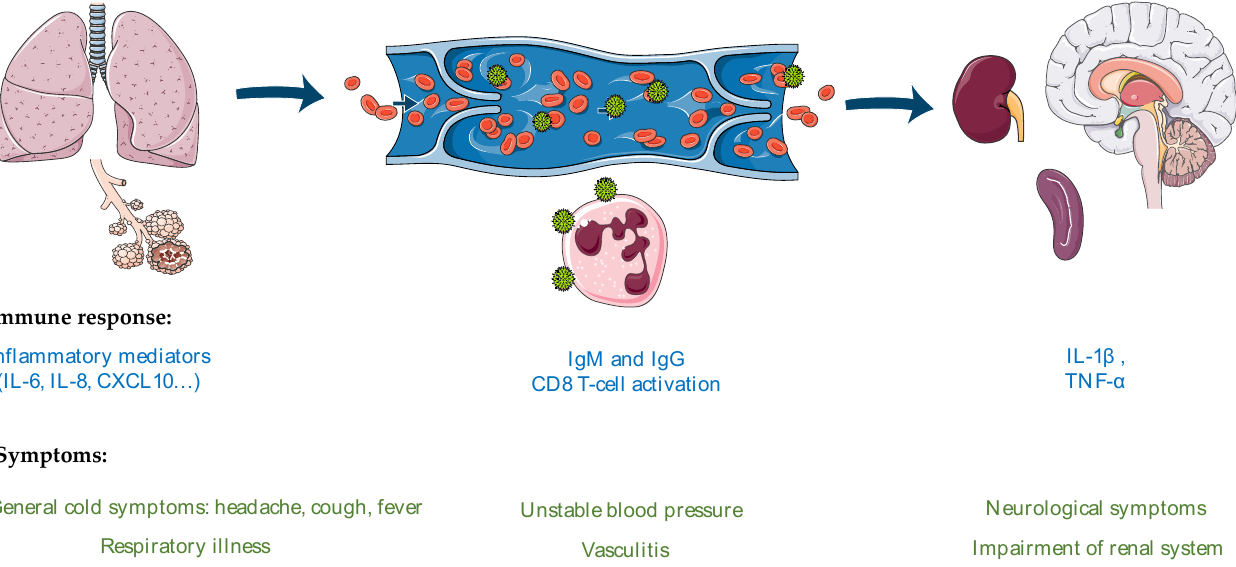
Figure 4. Henipavirus pathogenesis in humans. ( left ) During the initial state of henipaviruses infection, the respiratory tract and specifically the bronchi and alveoli are affected. Inflammatory mediators are released in consequence; ( middle ) In a second stage, the virus is systemically disseminated through the blood stream, either freely or attached to the surface of leukocytes; ( right ) In the late stage of infection, the virus reaches several organs such as the spleen, kidney and central nervous system (CNS), where the blood–brain barrier (BBB) is disrupted and cytokines such as tumor necrosis factor (TNF)-α and IL-1β are released, ultimately leading to the development of neurological signs.